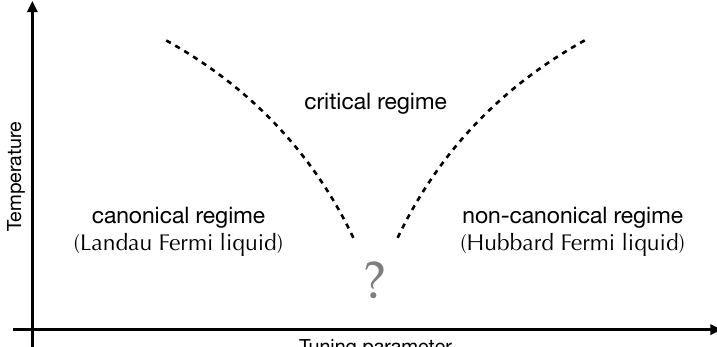
Figure 1: A schematic phase diagram for the metallic behaviour of correlated elec- trons. There are two distinct ways of organising electronic correlations, the canonical (Landau) description and the non-canonical (Hubbard) description, and critical be- haviour emerges where these compete. At low temperature there may be a first-order transition, as seen for example within DMFT [ 66 ] , or more generally this may be hid- den by an ordered phase, for example d -wave superconductivity in the case of the cuprate compounds [ 67 ]